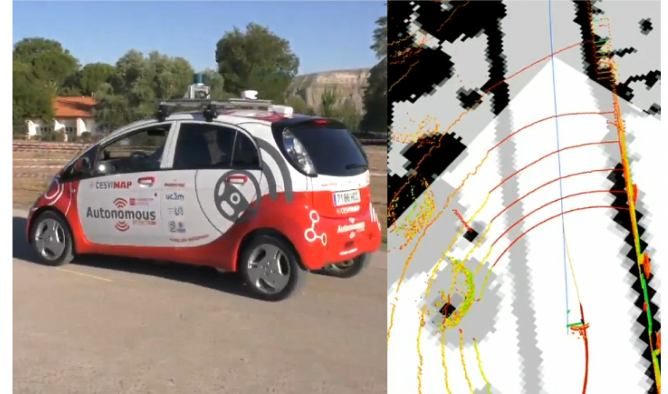
Figure 21. ( Left ) Autonomous vehicle platform used during the experiments. ( Right ) Visualization of the LiDAR point cloud (images obtained from